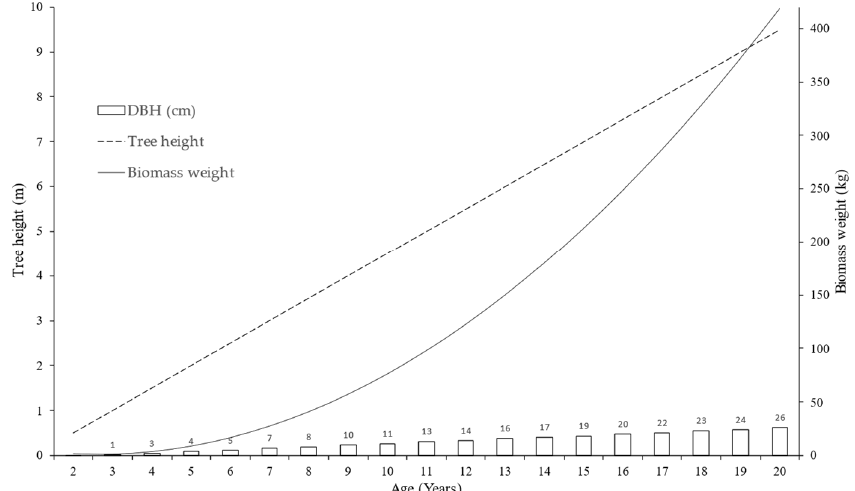
Figure 11. Height, diameter, and biomass weight estimation as a function of time.